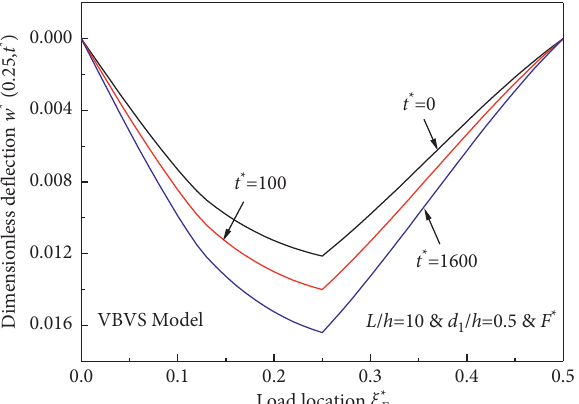
Figure 14: Response of dimensionless deflection w ∗ (0.25, t ∗ ) versus dimensionless load location coordinate ξ beams with different dimensionless time t ∗ .